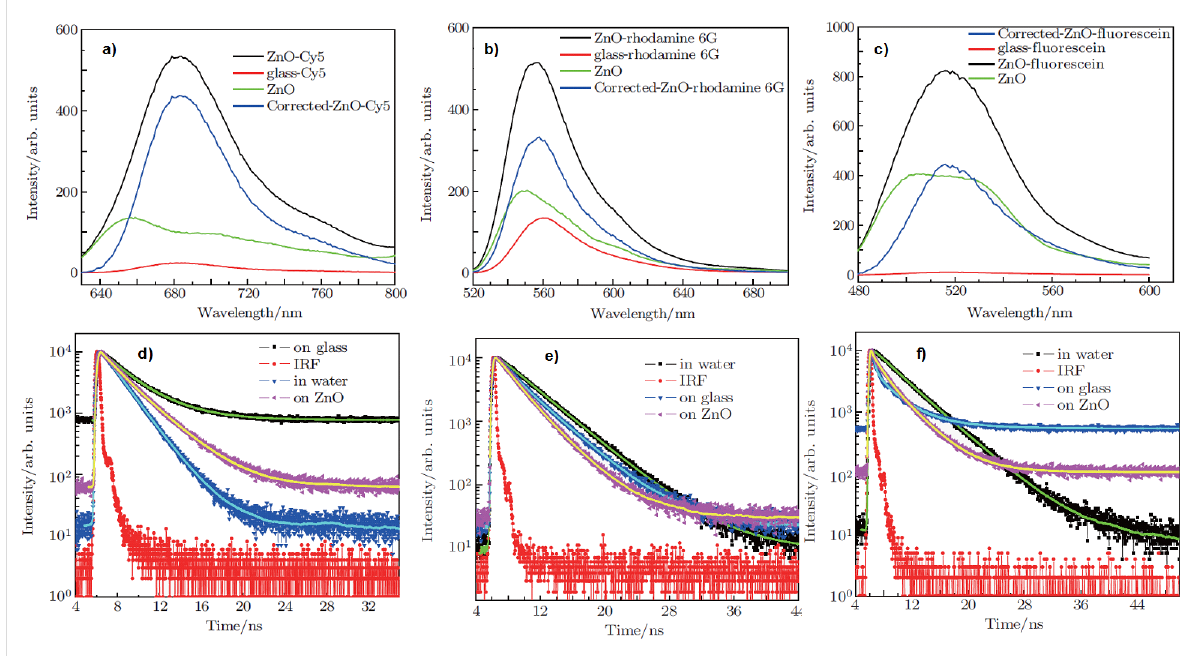
Figure 8: Fluorescence emission and kinetic traces characteristic to Cy5 (a and d), rhodamine 6G (b and e), and fluorescein (c and f) water solutions and to the respective spin-coated dye solutions on glass substrates with nanostructured ZnO films. Figure 8 was adapted from [115] (Y.-S. Liu et al., “Nanoscaled ZnO films used as enhanced substrates for fluorescence detection of dyes”, Chin. Phys. B, vol. 21, article no. 037803, published on 7 October 2011; https://doi.org/10.1088/1674-1056/21/3/037803); © 2012 Chinese Physical Society and IOP Publishing Ltd. Reproduced with permis- sion. All rights reserved. This content is not subject to CC BY